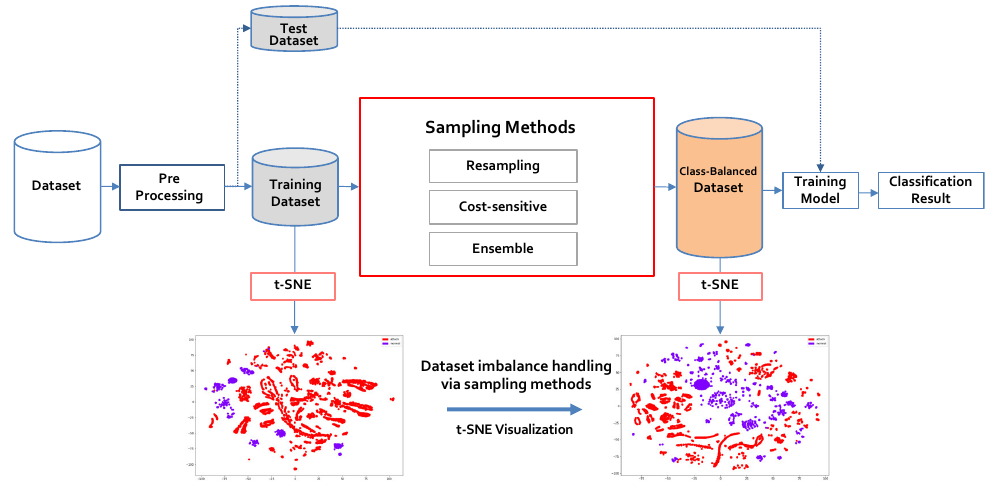
Figure 1. Sampling process for handling imbalanced classes.